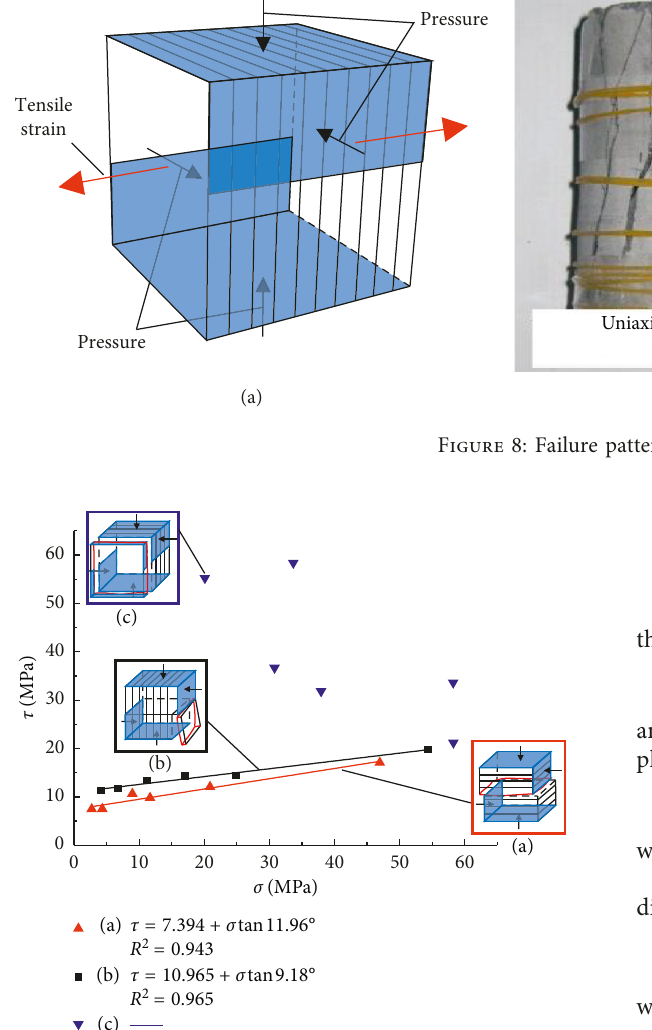
Figure 9: Failure patterns and shear test results with fitting Mohr − Coulomb curves under loading modes: (a), (b) and